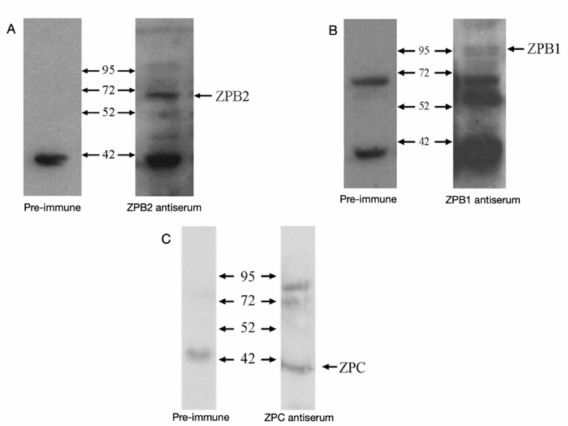
Figure 1. Western blot analyses for validation for anti-ZPB2 ( A ), anti-ZPB1 ( B ) and ZPC ( C ). The provided kDa sizes are based on the Spectra Multicolor BroadRange Protein Ladder that was elec- trophoresed and transferred from a gel that also contained duplicate 40 µ g samples of total protein isolated from the GD region of the IPVL from laid turkey eggs. The PVDF membrane containing the samples was cut into two strips, each containing the two protein samples, and then analyzed with preimmune serum or with immune serum containing the respective chicken anti-ZP